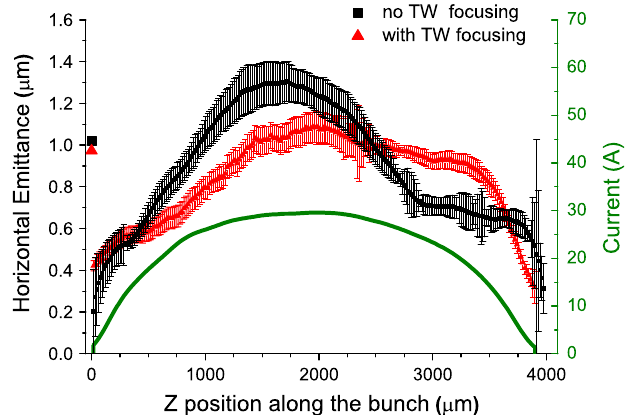
FIG. 9. Comparison between slice emittance of uncompressed beams, with TW solenoids on (red) and off (black). The points at z ¼ 0 represent the horizontal projected emittance reconstructed from the measured slice parameters. The green curve shows the current profile.